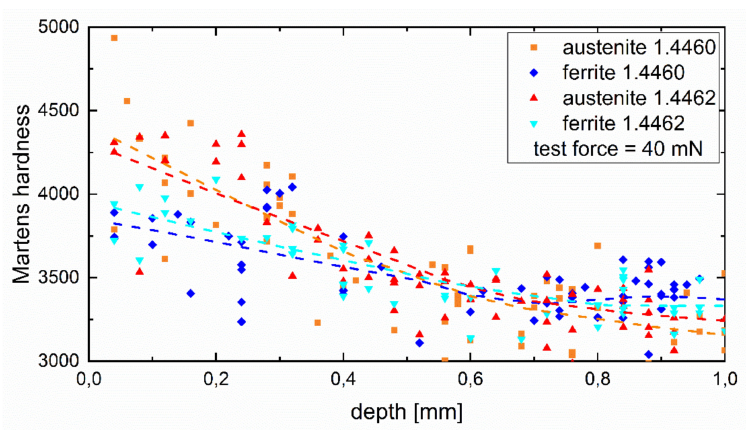
Figure 5. Phase-specific micro hardness of both investigated duplex steels. Much clearer evidence for the depth range of the work hardening being induced by the deep rolling process can be gained from the phase-specific evolution of the full width at half maximum (FWHM) of the diffraction lines of austenite and ferrite, as determined by means of lab X-ray diffraction and neutron diffraction, respectively. As an example, for the duplex steel 1.4462, the depth distribution of the phase-specific mean FWHM values are plotted for the lab X-ray experiments for the rolling direction (RD) and the feed direction (FD) on the left hand side diagram, and the corresponding results for the neutron diffraction experiment are shown on the right hand side image of Figure 6. Since the peak width of the diffraction lines depends, among other factors, on the diffraction angle, the instrument broadening and lattice defects [37], the values depicted in Figure 6 differ depending on the { hkl } plane and the applied wavelength used for diffraction analysis. In the present laboratory measurement series using X-ray diffraction, the 2 Θ line position for the unstressed lattice of the γ {220} line was around 128.3 ◦ , whereas the α {211} line was measured around 2 Θ ≈ 156.4 ◦ . In contrast, in the neutron experiment, the γ {311} line is measured at a detector angle of about 103.5 ◦ , but the ferrite α {211} line is measured at 2 Θ ≈ 91.5 ◦ . In consequence, the FWHM values for the unstressed lattice determined for the austenite {220} line is smaller than for the ferrite {211} line, but the FWHM value of austenite {311} line is larger than the ferrite {211} line determined in the neutron experiment. For one measurement series using identical measurement conditions, the FWHM values scale with the size of the coherently scattering regions and hence with the lattice imperfection density. In the current case, the change in FWHM values mainly scales with the dislocation density (see, e.g., [38–40]). In this regard, the increasing FWHM values in the near surface region correspond with the degree in work hardening induced by deep rolling. The higher depth resolution is achieved by means of X-ray diffraction analysis due to the small step-sizes for layer removal applied. Here, the depth distribution indicates that a depth of up to about 0.7 mm is affected by the deep rolling procedure, i.e., up to this depth, an increase in work hardening can be